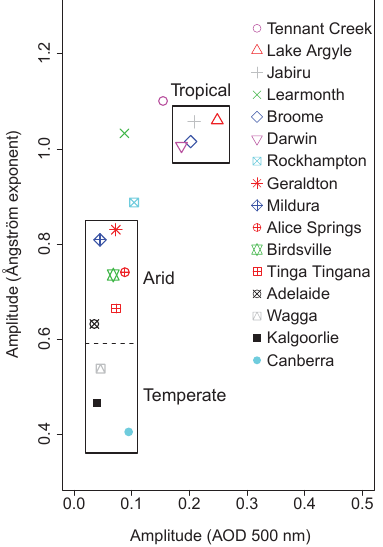
Figure 7. Plot of the periodic amplitudes of the Ångström exponent against aerosol optical depth at 500nm. The amplitudes were ob- tained from the peak-to-peak excursion of the fitted functions repre- senting the periodic component of the respective aerosol